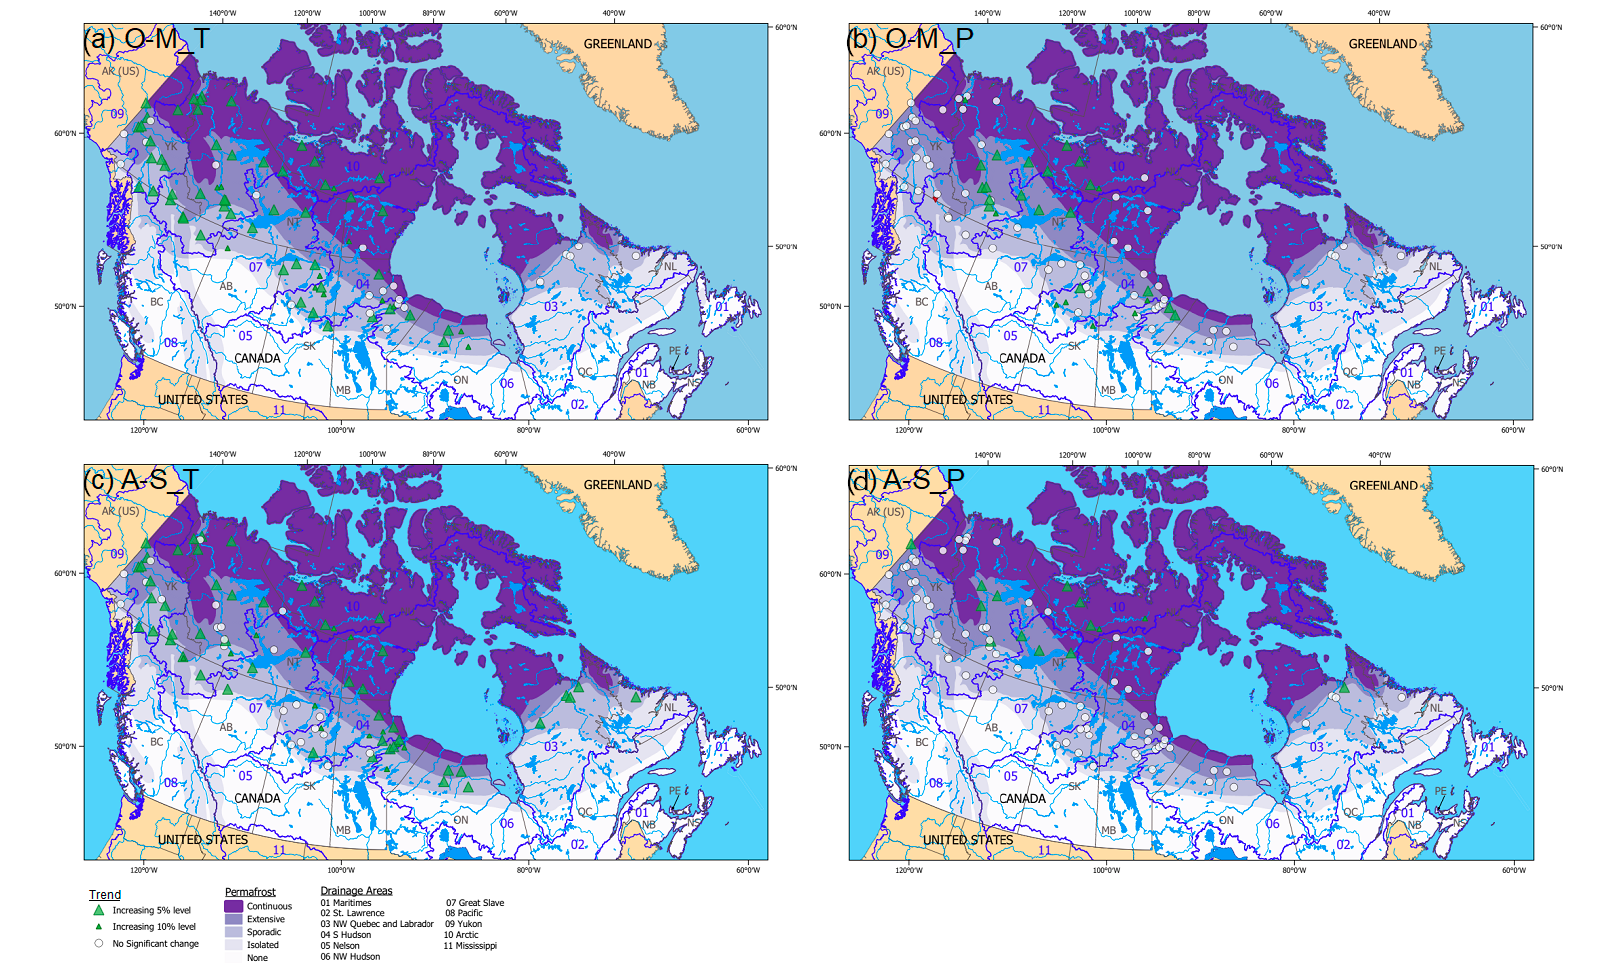
Figure 2. Historical trends in basin-averaged temperature and precipitation for the permafrost region of Canada: ( a ) October–March mean temperature (O–M_T); ( b ) October–March total precipitation (O–M_P); ( c ) April–September mean temperature (A–S_T); ( d ) April–September total precipitation (A–S_P). Significant increasing and decreasing trends at 5 and 10% levels are shown.